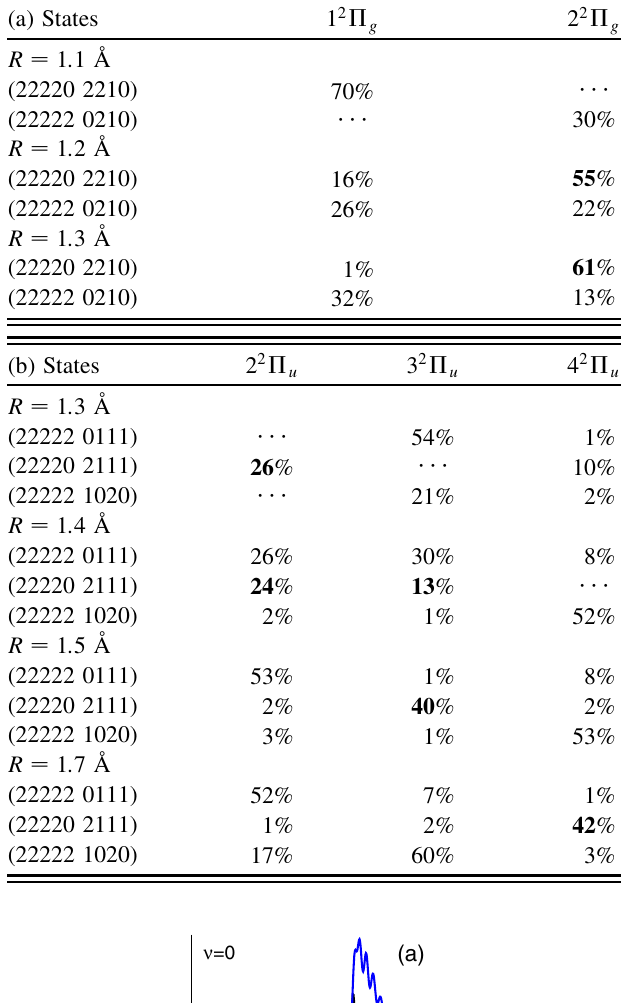
TABLE I. Leading electronic configurations for the adiabatic and 2 2 (cid:2) states and (b) 2 2 (cid:2) (a) 1 2 (cid:2) g g around the avoided crossing points. The configurations are abbreviated according to the N 2 ground-state configuration at